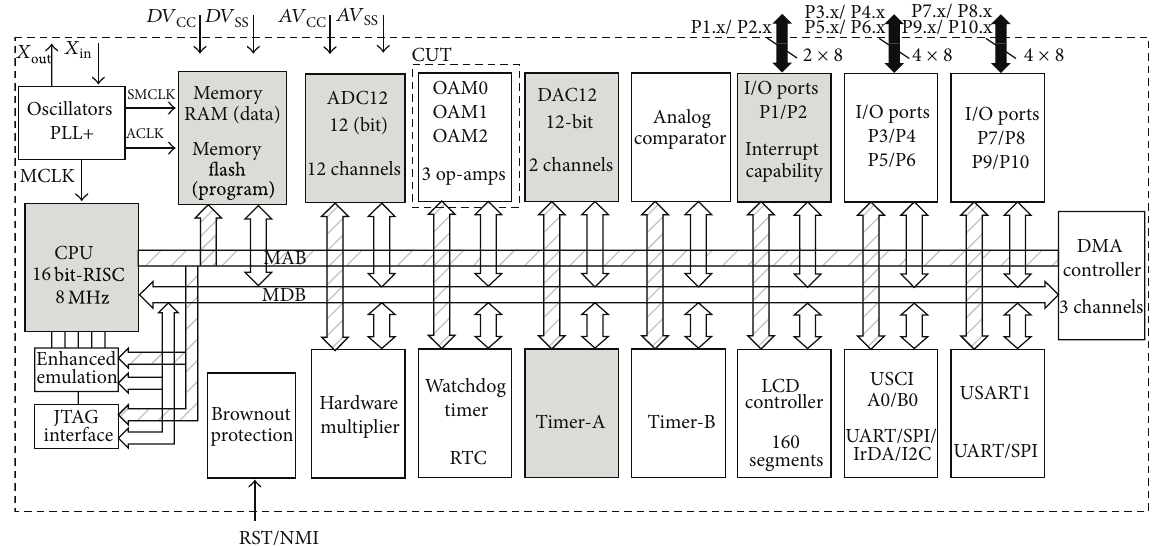
Figure 5: Block diagram of the MSP430FG4619 used as a case study.